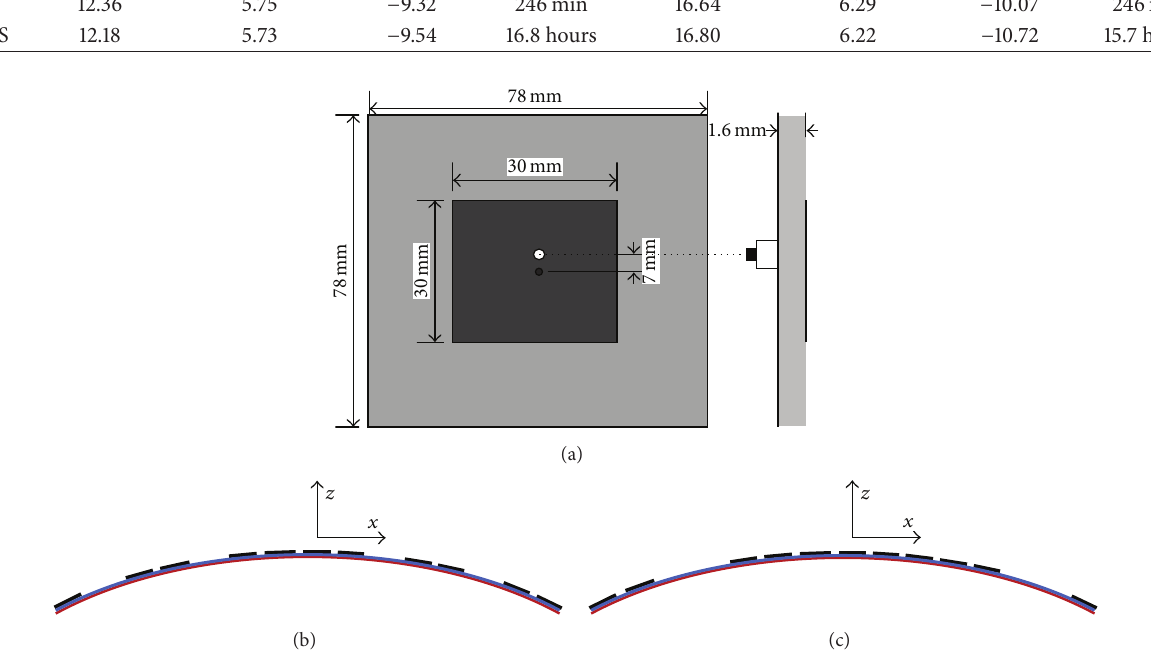
Figure 5: Geometries of nonlinear thinned arrays. (a) Structure of the patch antenna element, (b) side view of array 1, and (c) side view of array 2.